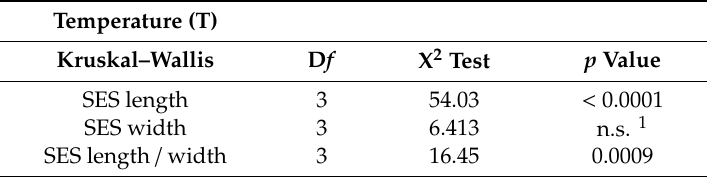
Table 3. One-way analysis of variance for length, width, and ratio between length and width of SES produced from P. halepensis megagametophytes induced under di ff erent temperature treatments (23 ◦ C,